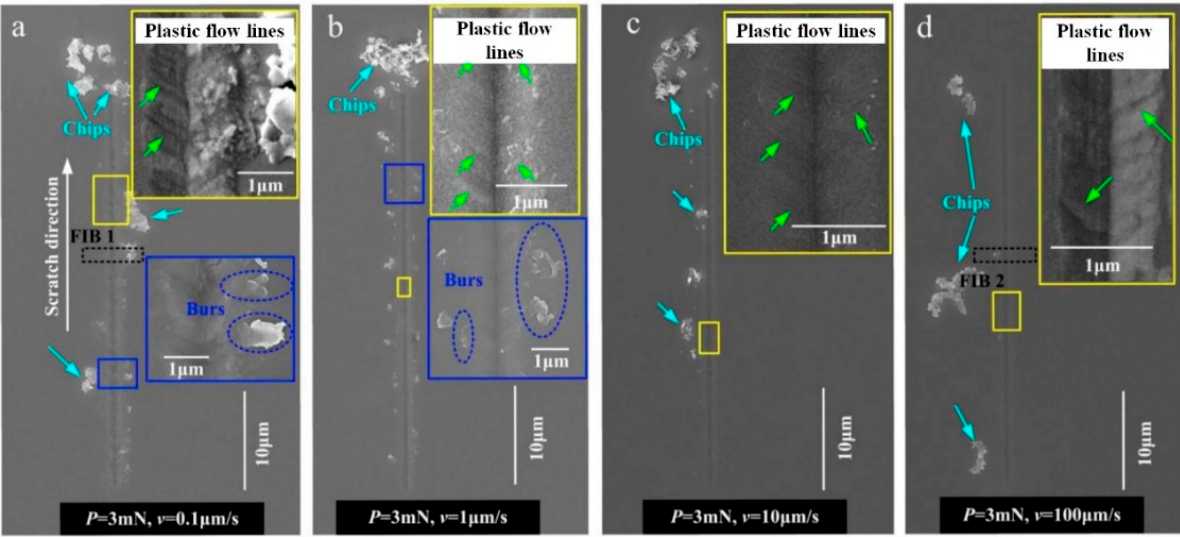
Figure 5. Effect of strain rates caused by different scratching speeds on surface morphology [49].